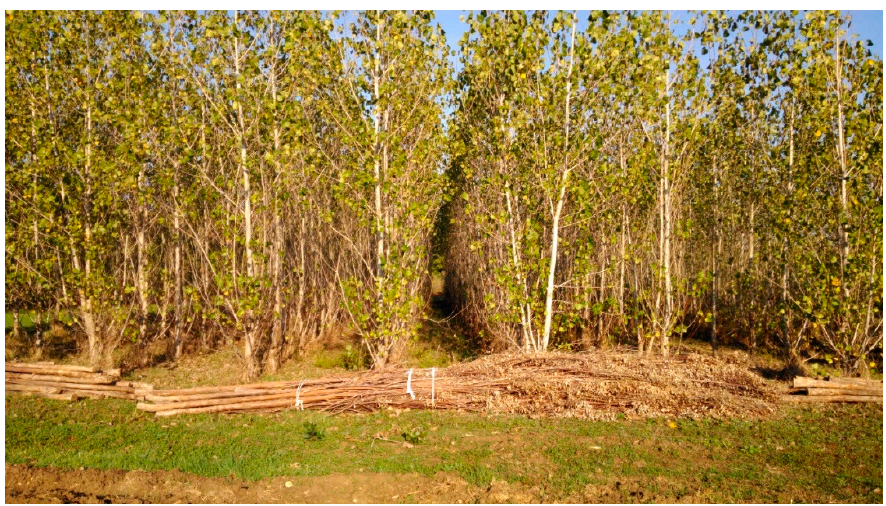
Figure 3. Eucalyptus whole-stem storage with branches (WSB).